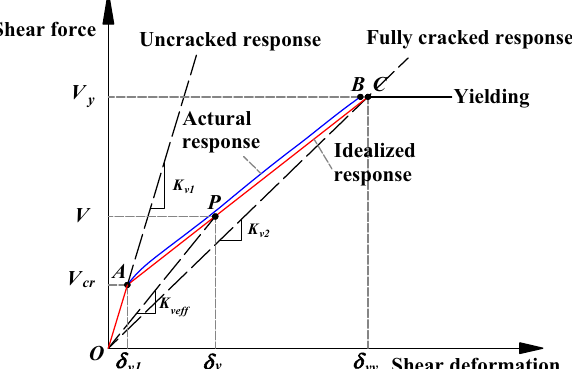
Fig. 6 Diagram of effective shear stiffness of RECC columns.